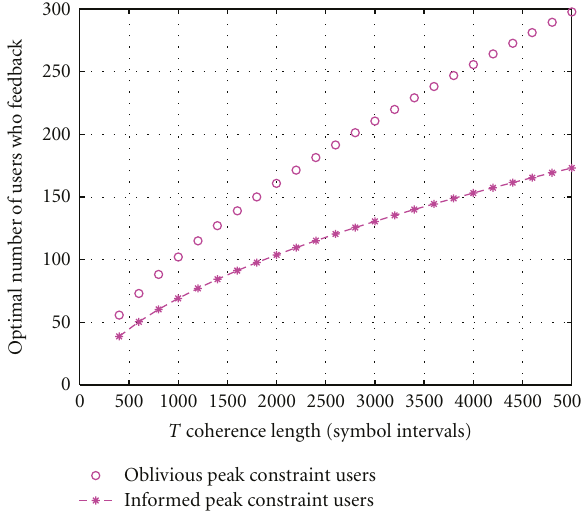
Figure 7: Optimal number of users versus coherence length.